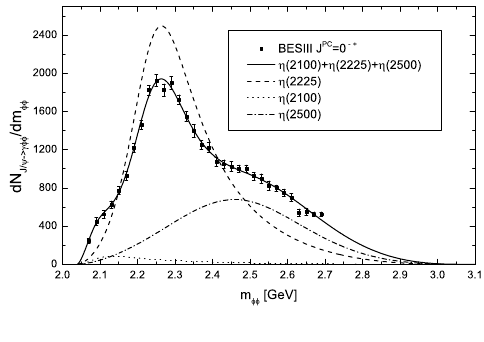
Figure 1. Fitting the 0 − component in the model